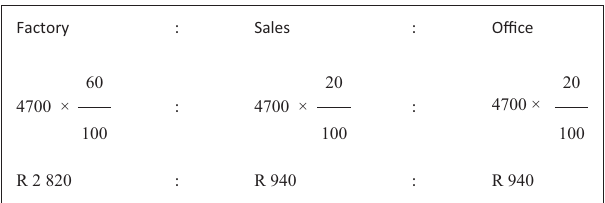
FIGURE 6: Examples of financial ratios.